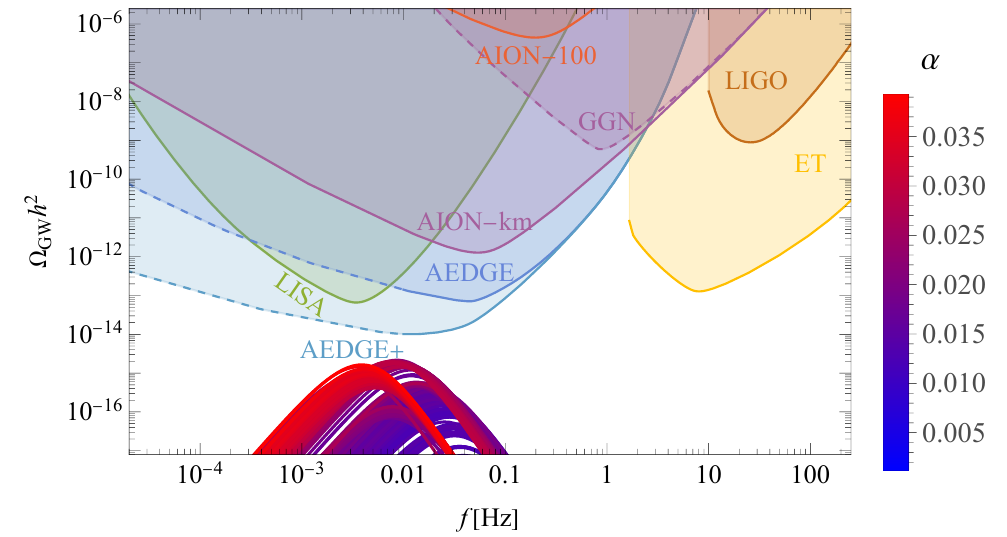
Figure 6 . Gravitational wave spectra from points with bubble walls that are not very relativistic, for which we find hydrodynamical